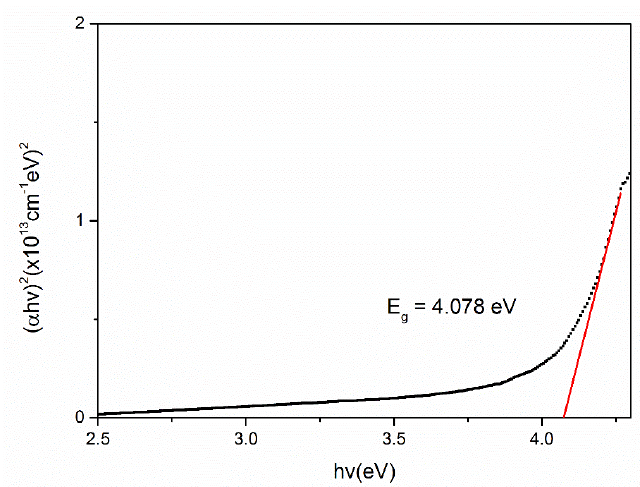
Figure 7. Optical band gap for chitosan thin film.